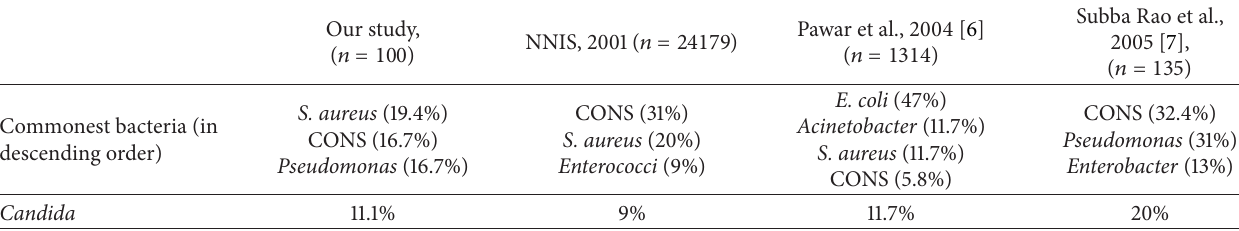
Table 5: Comparison of various organisms found in different studies.